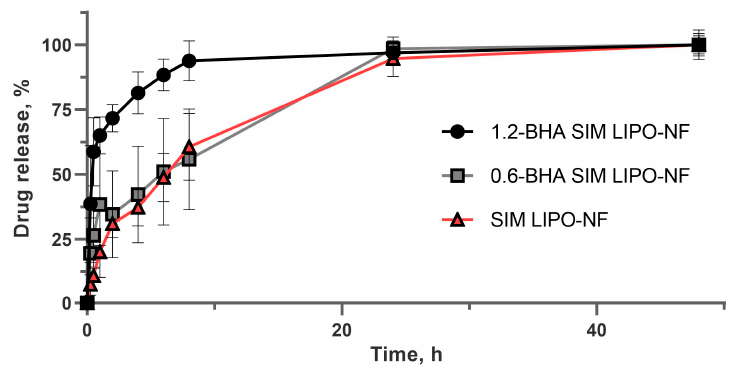
Table 3. MADLS and particle concentration results of the dissolved LIPO-NF samples.